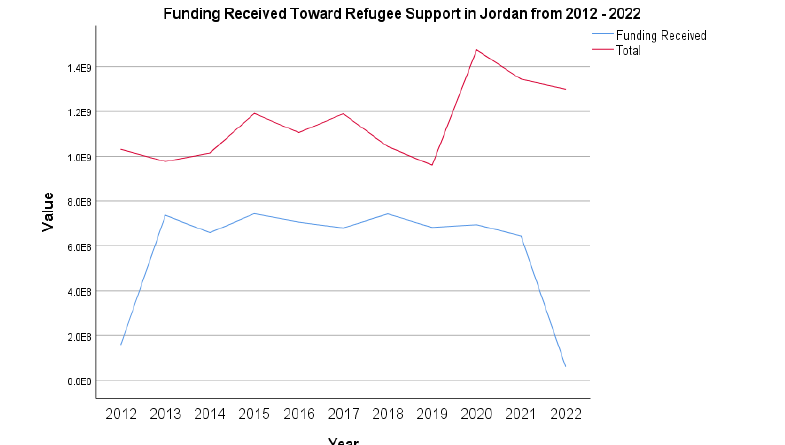
Figure 2: Funding Received for Refugee Support (Source: Author‘s research